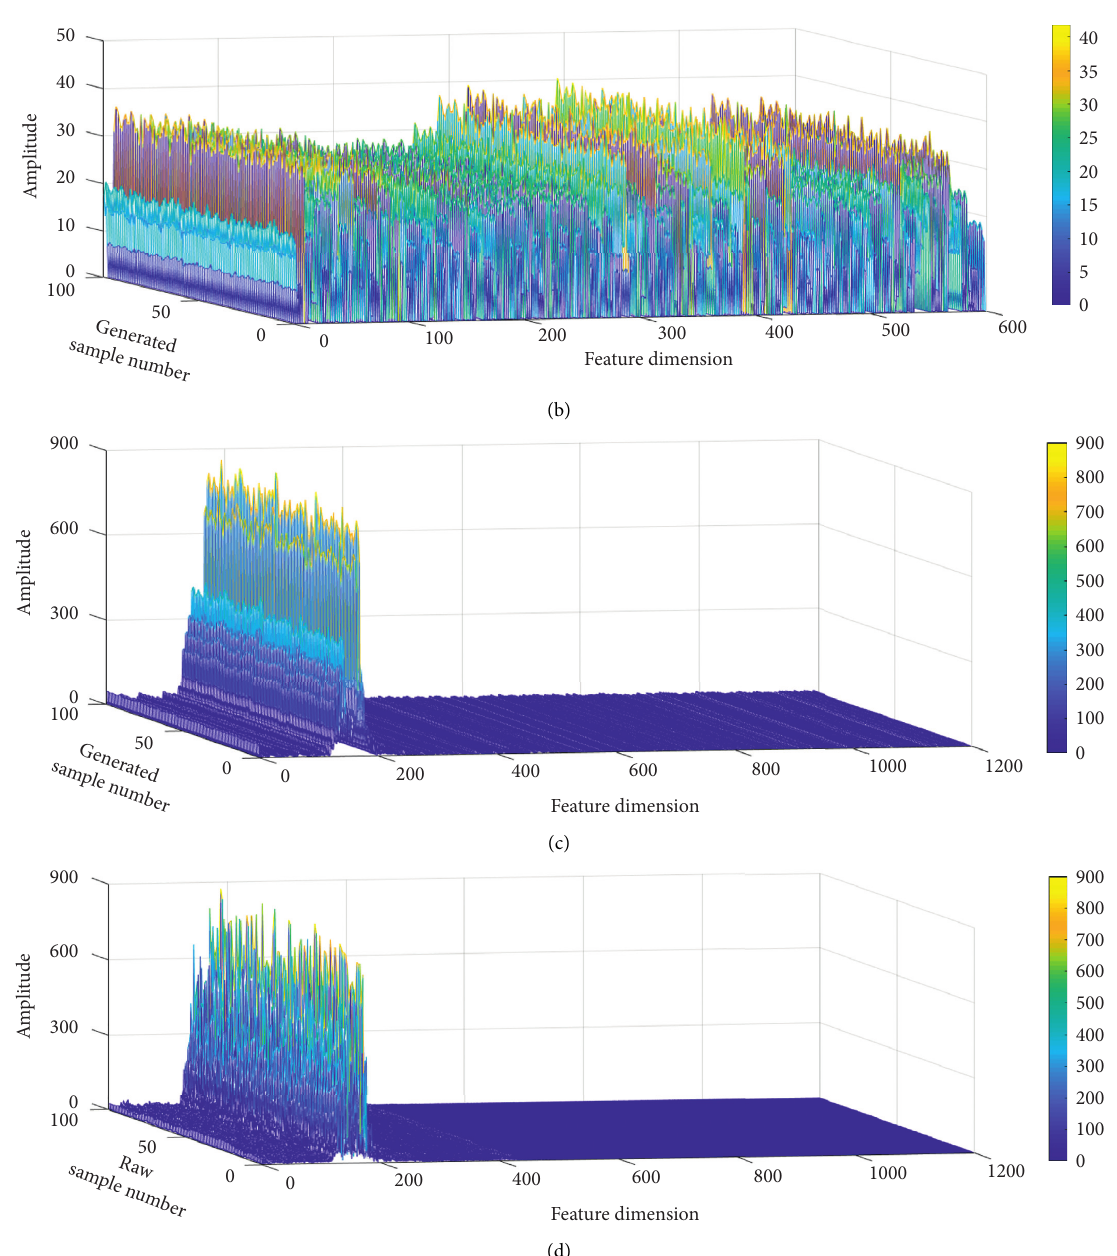
Figure 4: The extracted features of the generator for OF3 samples: (a) the first hidden layer, (b) the second hidden layer, (c) the output layer, and (d) the raw OF3